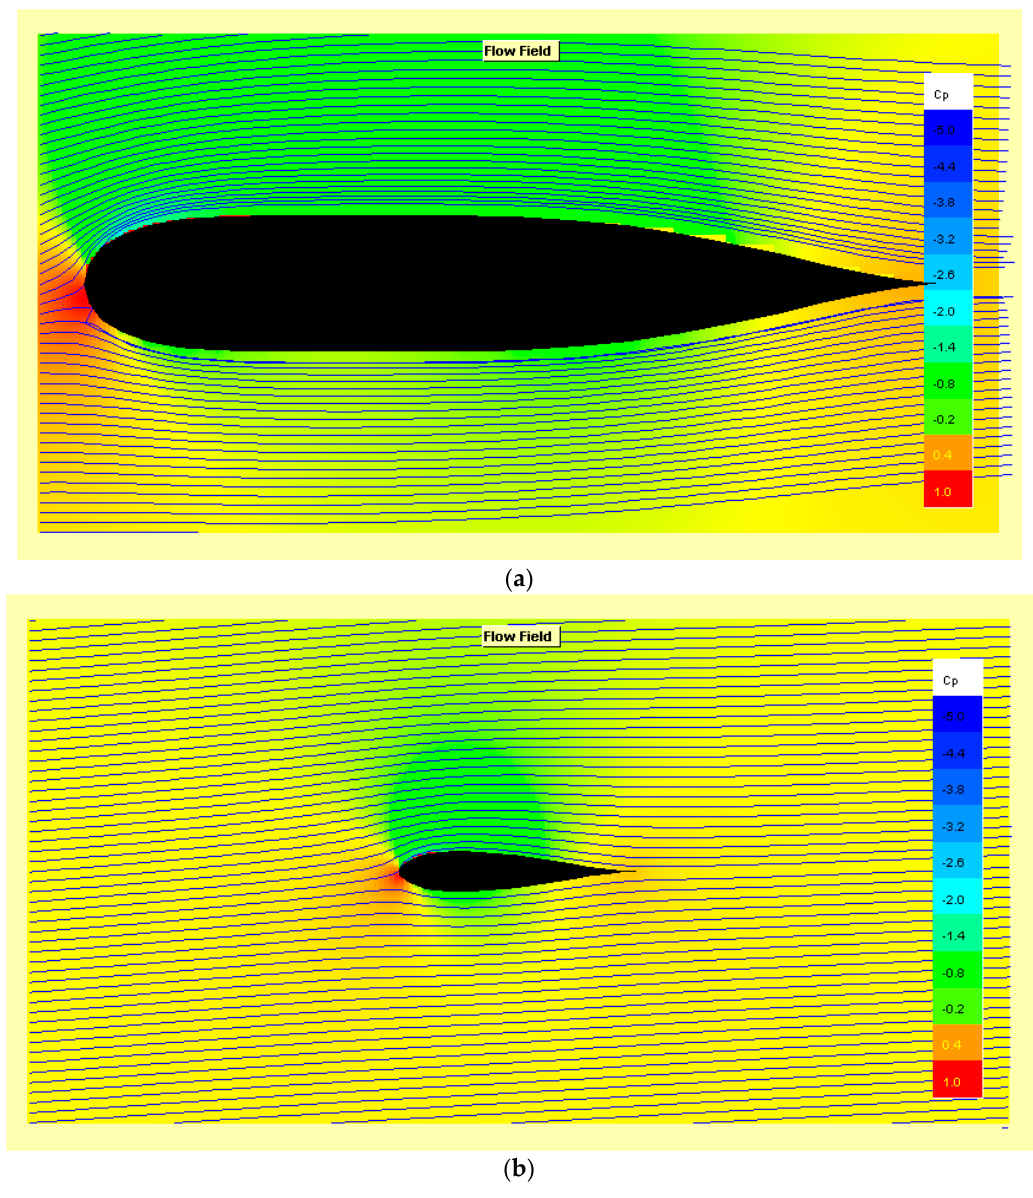
Figure 9. Flow field and pressure gradient of conditions: Speed = 0.52 kts, R e = 10 4 and α att = 3.3 ◦ , ( a ) Body profile of the drone; ( b ) Eppler 838 Aerofoil.